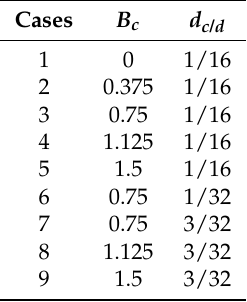
Table 2. The values of parameters B c and d c adopted for the calculations in this study.